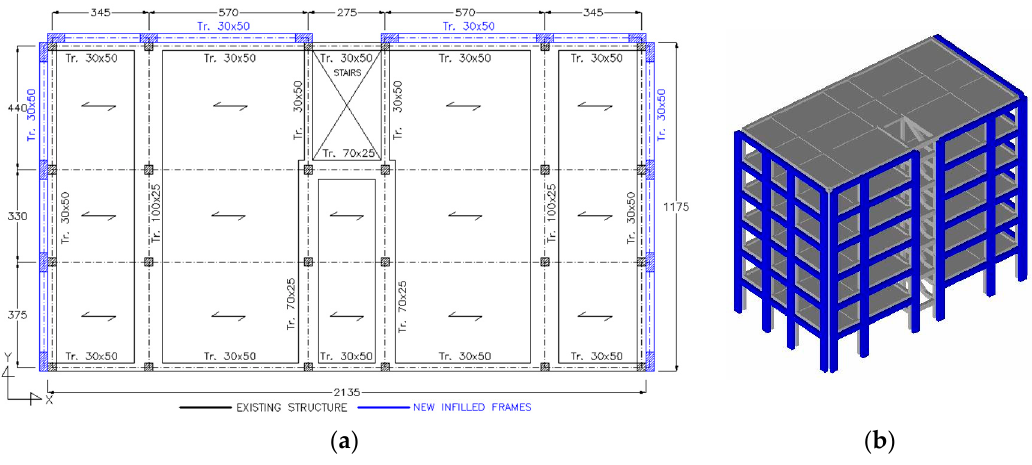
Figure 10. C3 configuration: in plan layout of the retrofitted building ( a ) and 3D view of the model ( b ). External frames designed to have a significant contribution for the resistance to seismic loads are highlighted in blue.